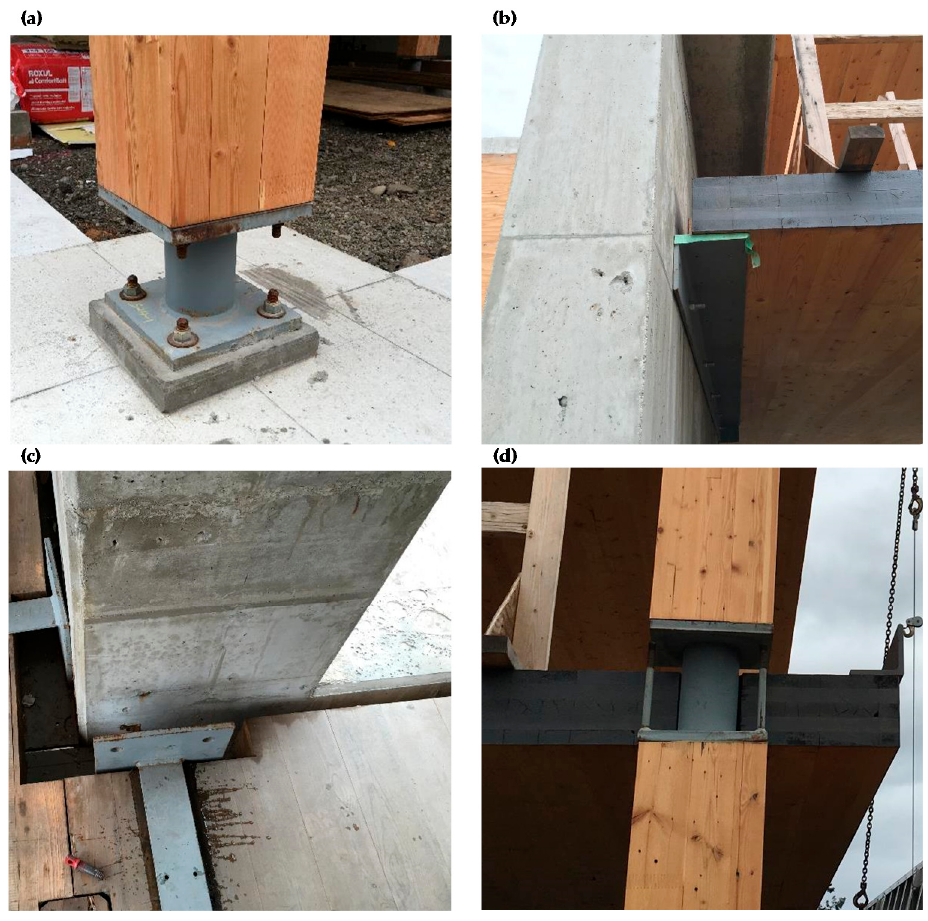
Figure 2. Joints: ( a ) Column-to-slab connections, ( b ) ledgers for floors, ( c ) steel drag strap connections for floors and ( d ) vertical connections for columns.